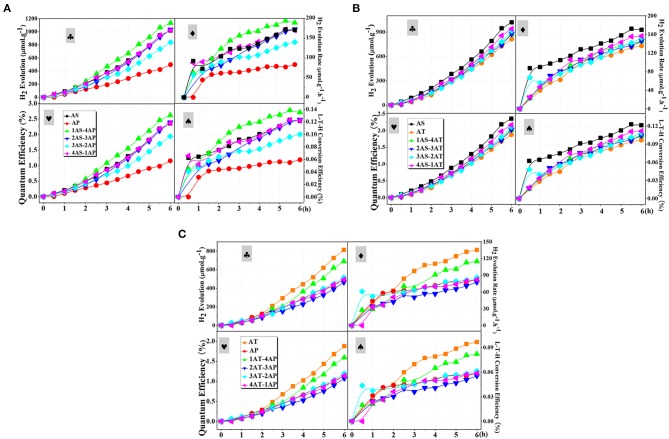
Typical time course of:  H2 production amount,  hydrogen evolution rate,  quantum efficiencies, and  light-to-hydrogen energy efficiencies over the as-prepared photocatalysts in 7 vol.% aqueous solution of glycerol for different mixing binary component systems: (A) AS-AP, (B) AS-AT, and (C) AP-AT. AS, Ag2O-TiO2 nanosphere; AP, Ag2O-TiO2 nanoplate; AT, Ag2O-TiO2 nanotube.